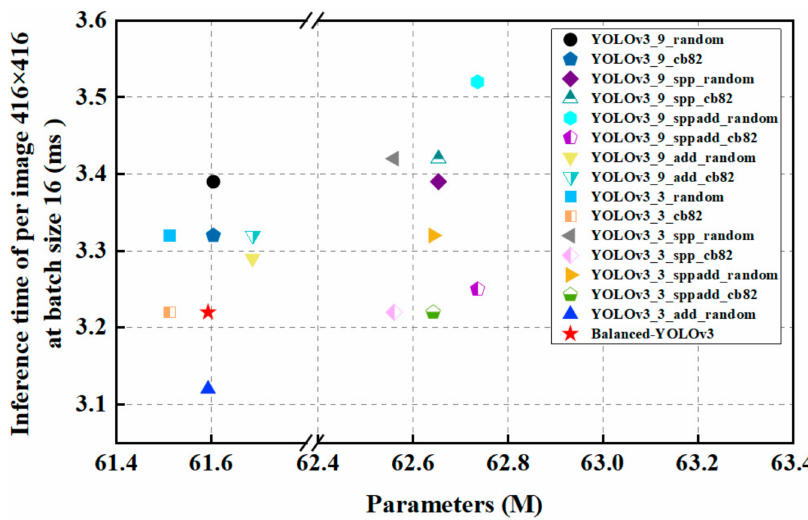
Figure 12. Parameter-Inference Time